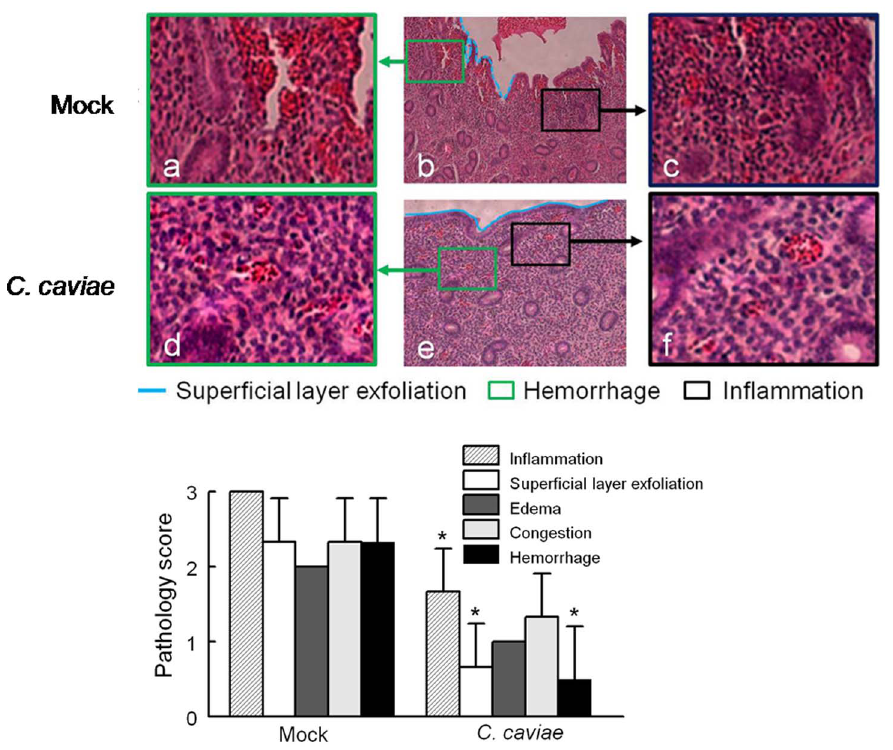
Fig. 4. Effect of C. caviae Vaccination on Histopathological Lesions in the Genital tract from Guinea pigs following Chlamydial Challenge. The genital tracts from each humanely euthanized guinea pig were removed at day 80 post C. caviae challenge fixed and embedded and then sectioned, and analyzed microscopically after H&E staining. (A) Representative photomicrographs of histological sections from uterine tissues are shown for each group of challenged guinea pigs with C. caviae EB vaccination (EB, n 5 3) or mock vaccinated (Mock, n 5 3). The superimposed images are magnifications of the regions of the indicated boxes to show details of inflammatory cell infiltration (c and f) and hemorrhage (a and d). Original magnification of the images (b and e) is 6 200, while a, c, d and f are 6 400. The light blue dash lines mark superficial layer exfoliation of the endometrial epithelium of the uterus (b), whereas the light blue solid lines indicate the intact endometrial epithelium of the uterus (e). Histopathological injury scores were calculated from five distinct morphological parameters (inflammatory cell infiltration, superficial layer exfoliation, edema, congestion and hemorrhage) in the uterus (B). Scores were calculated by examination of 5 consecutive sections (2 mm- interval) in every animal. Graphs expressed as mean ¡ SD, and compared using paired t - test. The asterisk indicates statistically significant differences (* p , 0.05) between the C. caviae group and the mock group for the respective